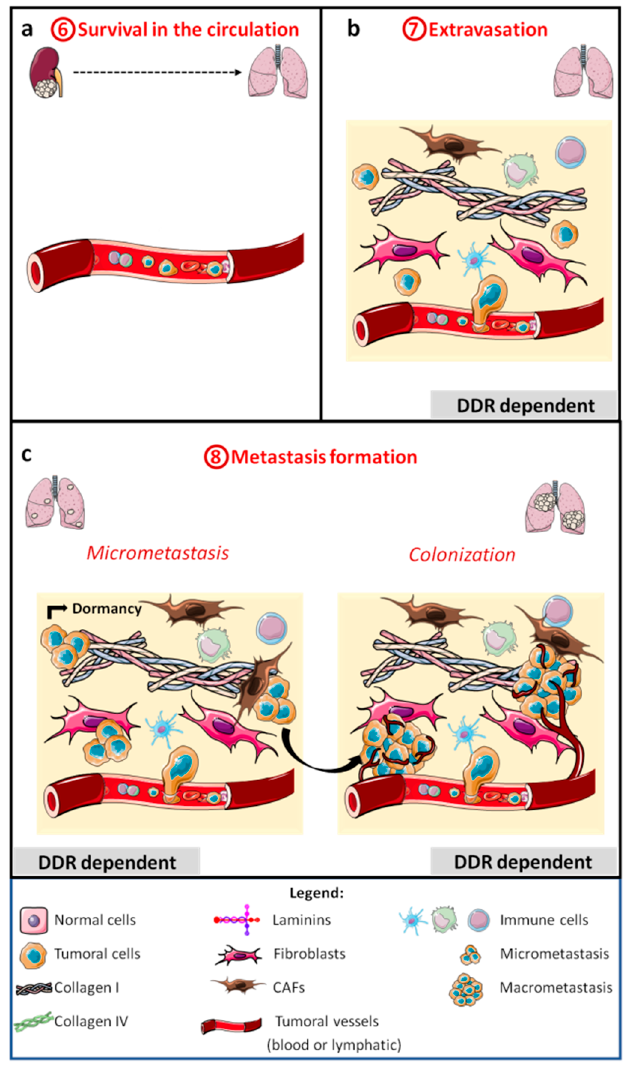
Figure 3. Schematic representation of the late metastatic stages: survival in the circulation ( a ), extravasation ( b ), micrometastasis, and colonization or macrometastasis formation ( c ). DDRs are a family of tyrosine kinase receptors (TKRs) with two members, DDR1 and DDR2. DDRs share an extracellular domain similar to the discoidin I lectin of the amoeba Dictyostelium discoideum , a discoidin-like domain, and an extracellular juxta-membrane do- main (EJXM). The transmembrane domain is followed by an intracellular juxta-membrane domain (IJXM) and by the tyrosine kinase domain (TKD). DDR1 and DDR2 are encoded by single genes present in chromosome 6 (6p21.33) and 1 (1q23.3), respectively.